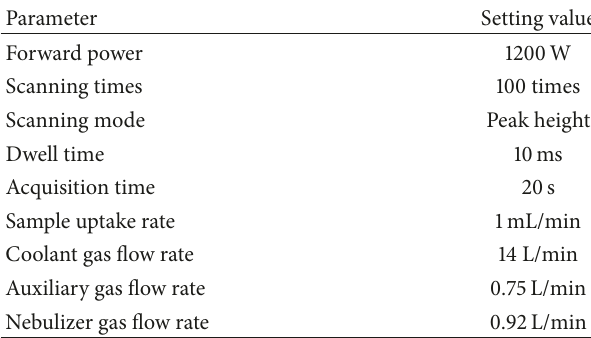
Table 2: Optimized instrumental conditions and parameters of the